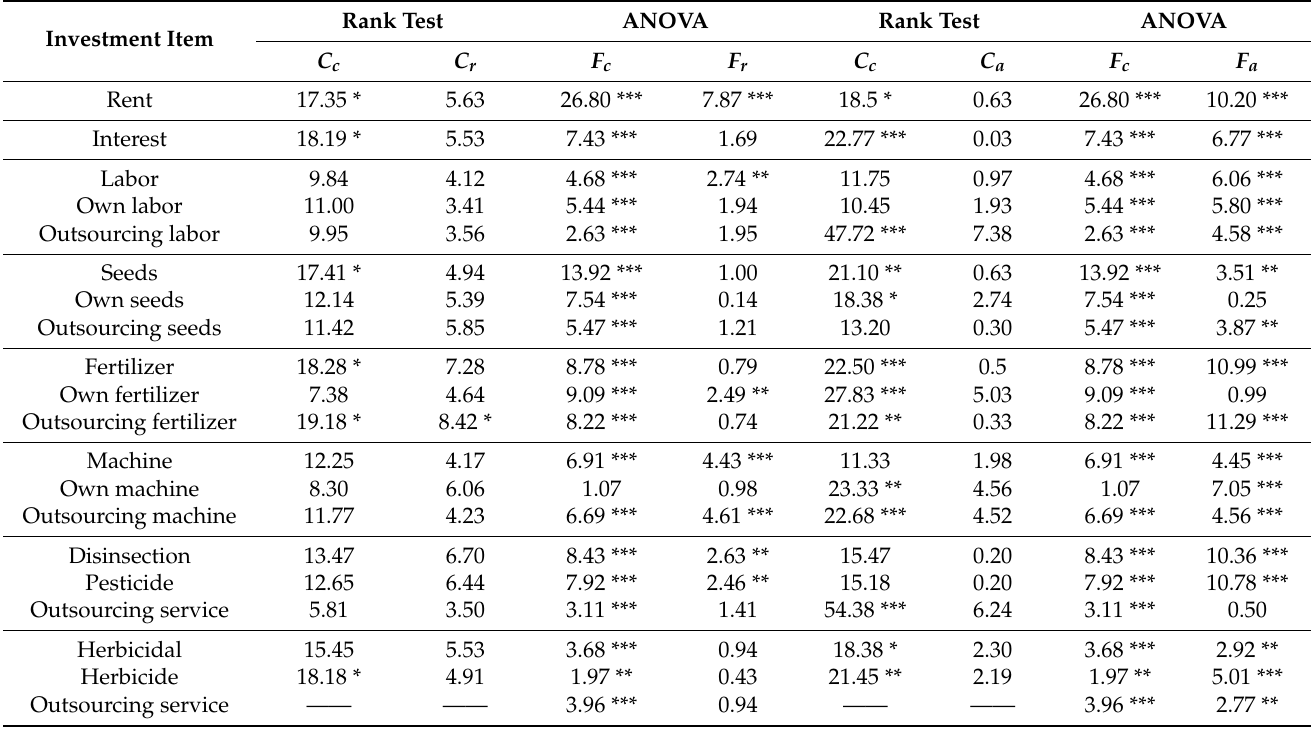
Table 6. Transaction Costs versus Risk tolerance and Area efficiency comparisons using two-factor rank test and ANOVA. Investment